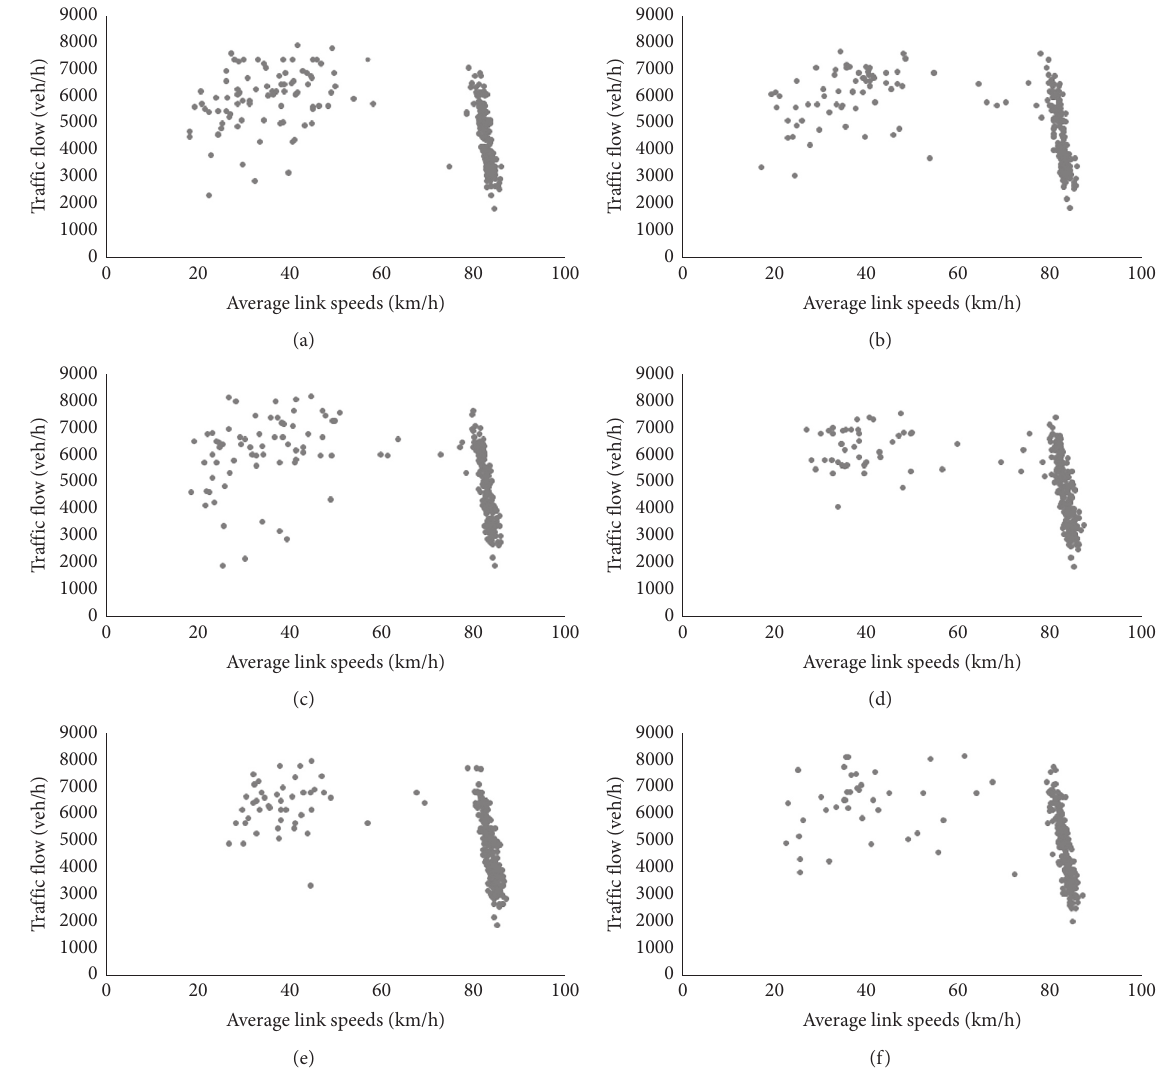
Figure 4: Speed-flow diagrams on Link 7. (a) No CAVs. (b) CAVs account for 1%. (c) CAVs account for 3%. (d) CAVs account for 5%. (e) CAVs account for 7%. (f) CAVs account for